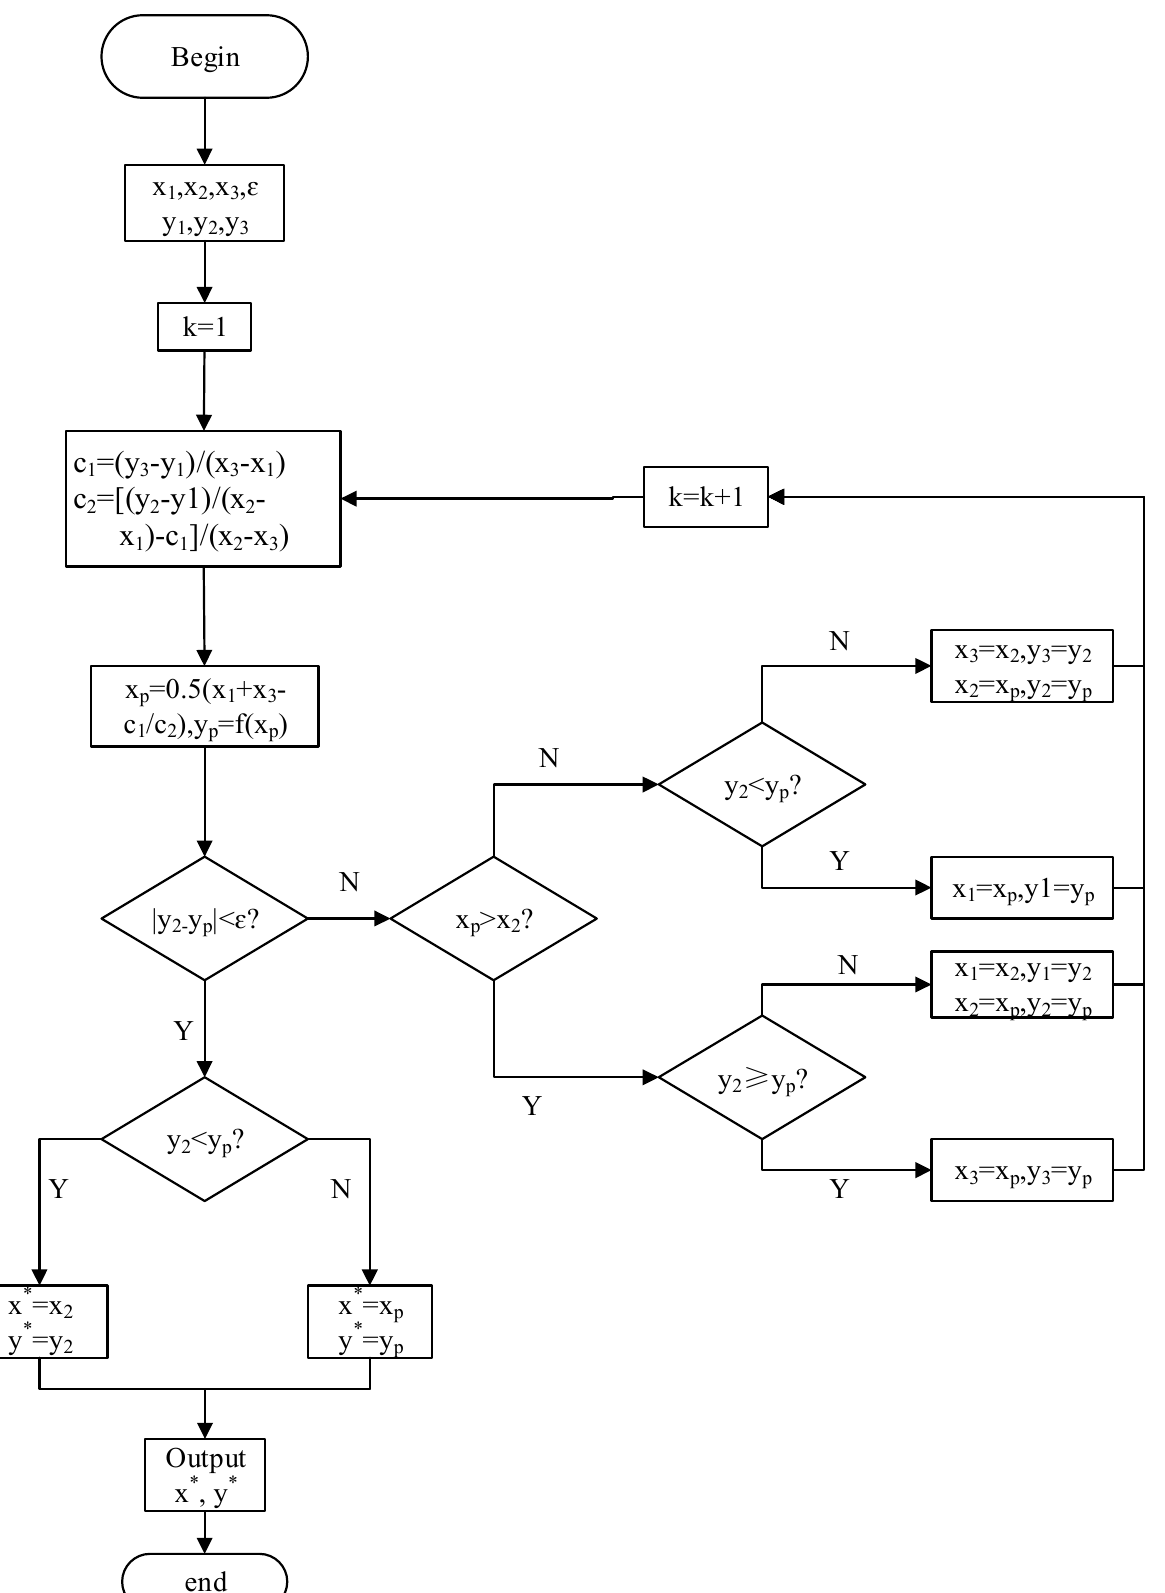
Figure 2. Flow diagram of quadratic interpolation optimization algorithm.